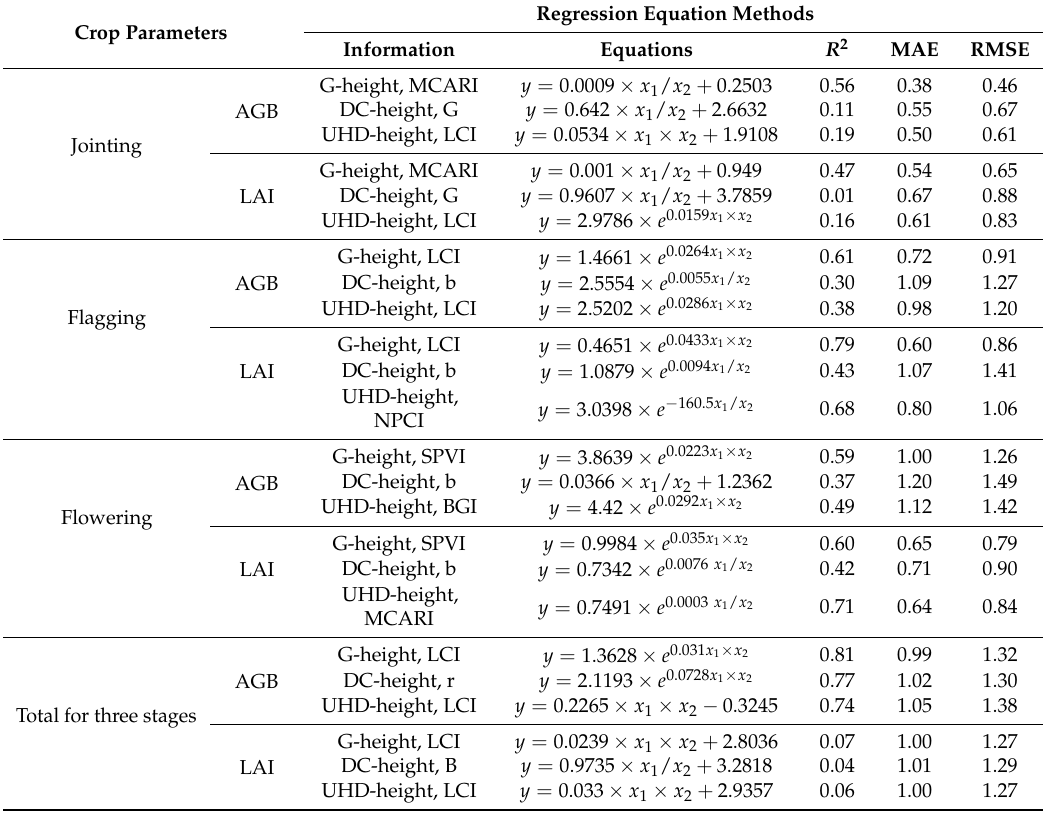
Table 6. Relationship between crop parameters and spectral VIs and crop height in different growing